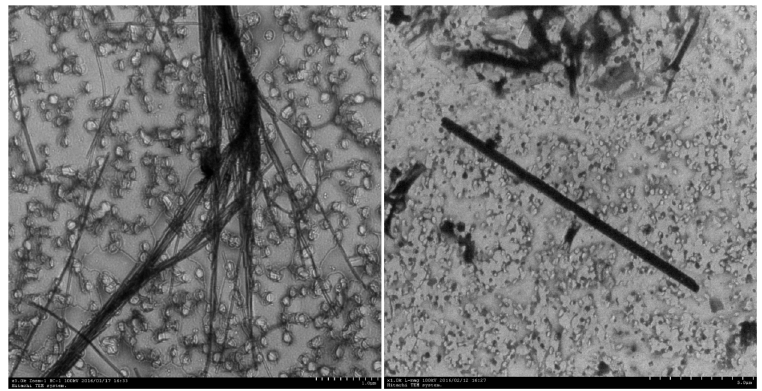
Fig 4. Transmission electron microphotograph of serpentine and amphibole asbestos (samples were respirable referencematerialsfrom RTI).